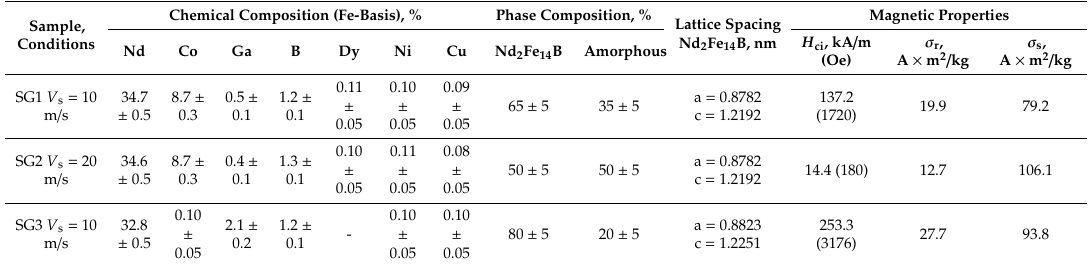
Table 1. Chemical composition, results of the quantitative phase analysis and magnetic properties of the melt quenched samples.